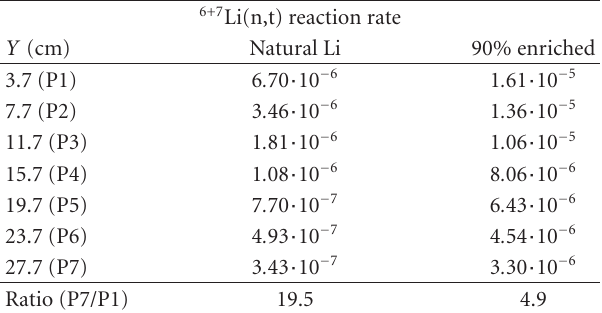
Table 1: Calculated Tritium production rates. (TORT/FENDL-2.1: S-16,P-5)